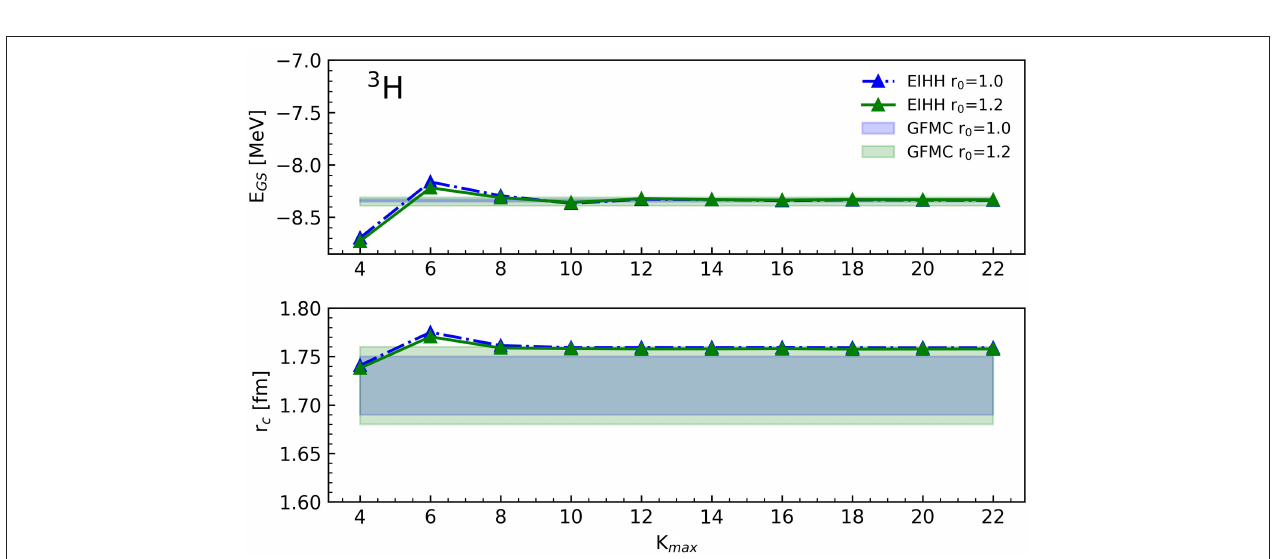
FIGURE 3 | The ground-state energy and the charge radius of the nuclear 3 H system as a function of the grand-angular momentum quantum number K max . The green and blue error-bands are the GFMC results with the relative statistical